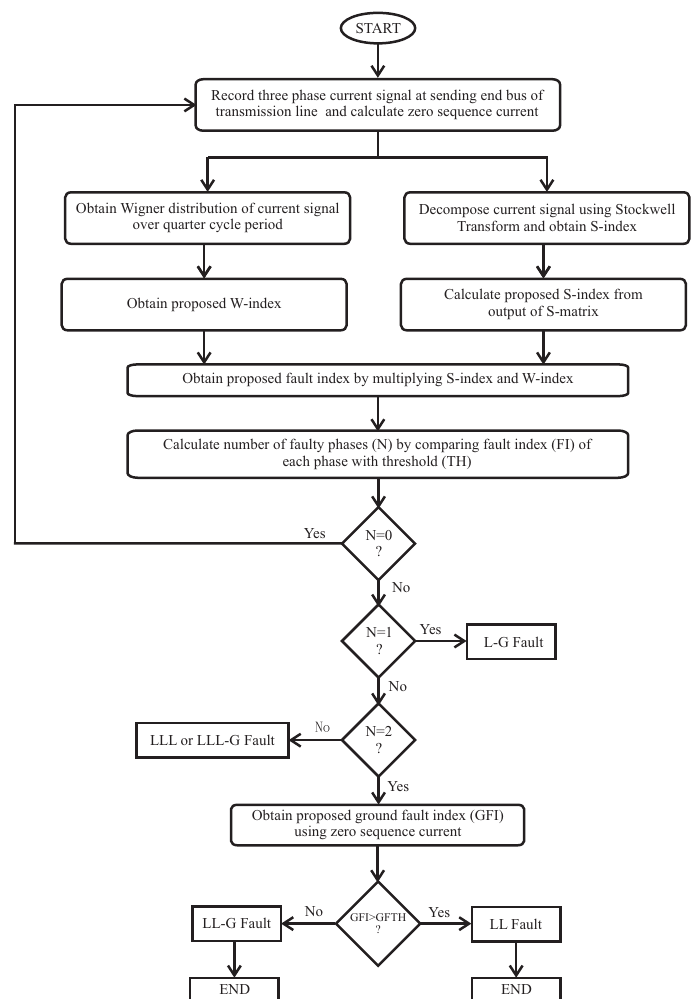
Figure 2. The proposed technique’s